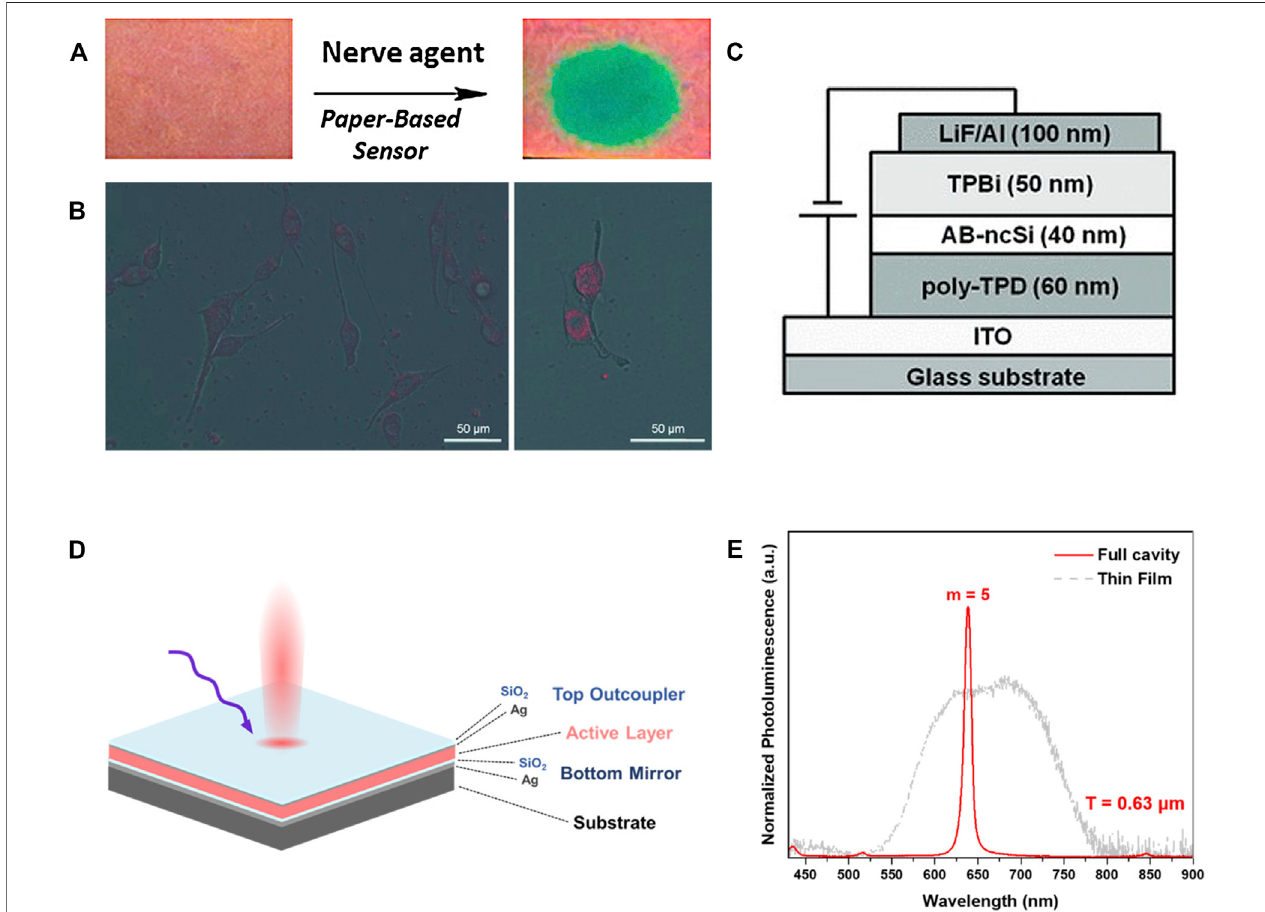
FIGURE 7 | (A) Images of SiNCs coated fi lter paper spotted with PX and a blank control under the irradiation of UV light (365 nm), reprinted with permission from Robidillo et al. (2019). Copyright 2019 American Chemical Society. (B) SiNCs loaded SLN within the MDA435 human breast cancer cells emitted red PL under the irradiation of 458 nm light, reprinted with permission from Henderson et al. (2011). Copyright 2011 WILEY-VCH Verlag GmbH & Co. KGaA, Weinheim. (C) Schematic representation of the device containing allylbenzene-capped SiNCs (AB-ncSi) as the emissive layer, reprinted with permission from Mastronardi et al. (2012). Copyright 2012 WILEY-VCH Verlag GmbH & Co. KGaA, Weinheim. (D) Illustration of SiNCs-polymer Fabry-Pérot microresonator and (E) the spectra of SiQD-polymer hybrid/blend with (solid line) or without (dashed line) Fabry-Pérot cavity structure, reprinted with permission from Cheong et al. (2021). Copyright 2021 American Chemical